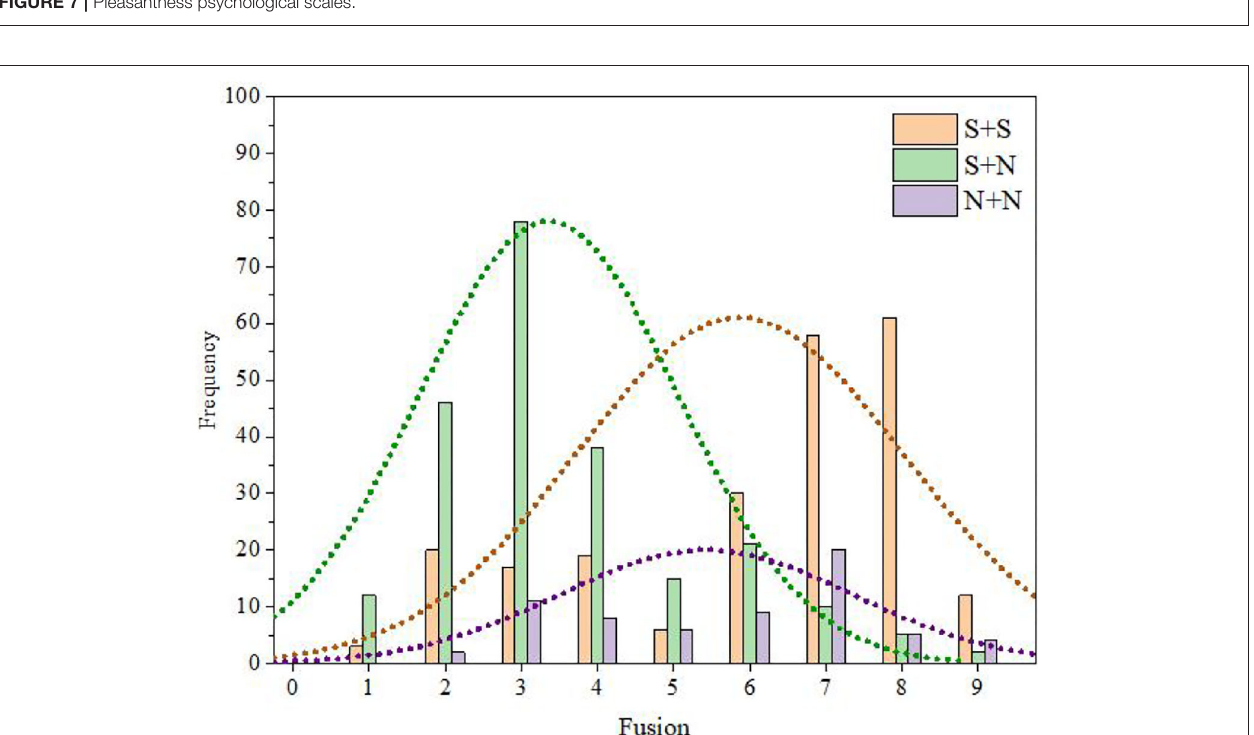
FIGURE 8 | Distribution statistical histogram of fusion